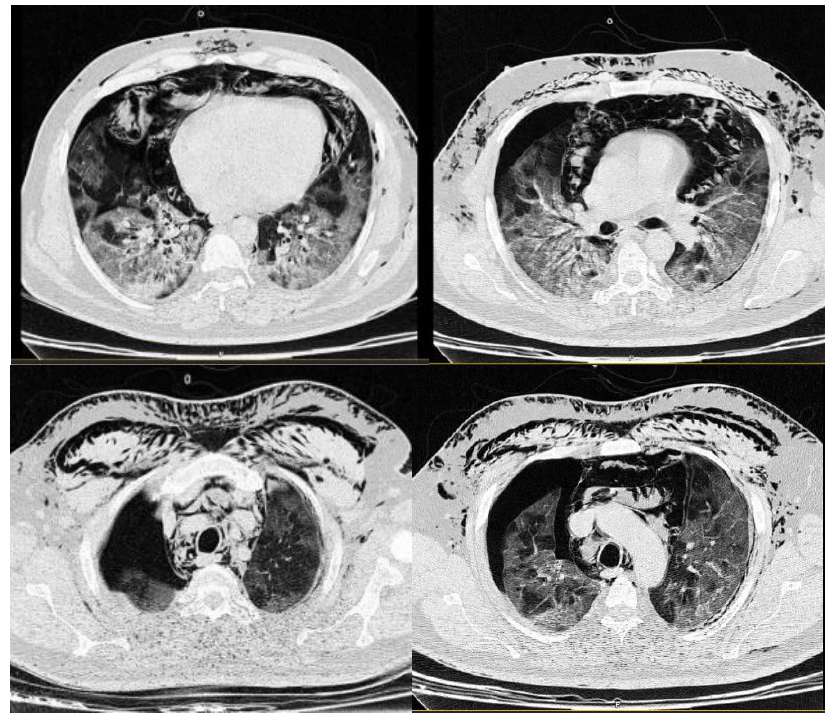
Figure 1 . Baseline chest CT scan of the cases